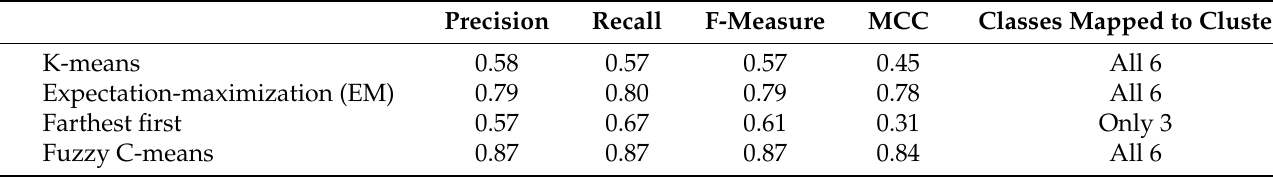
Table 2. Overall Precision, Recall, F -measure, and